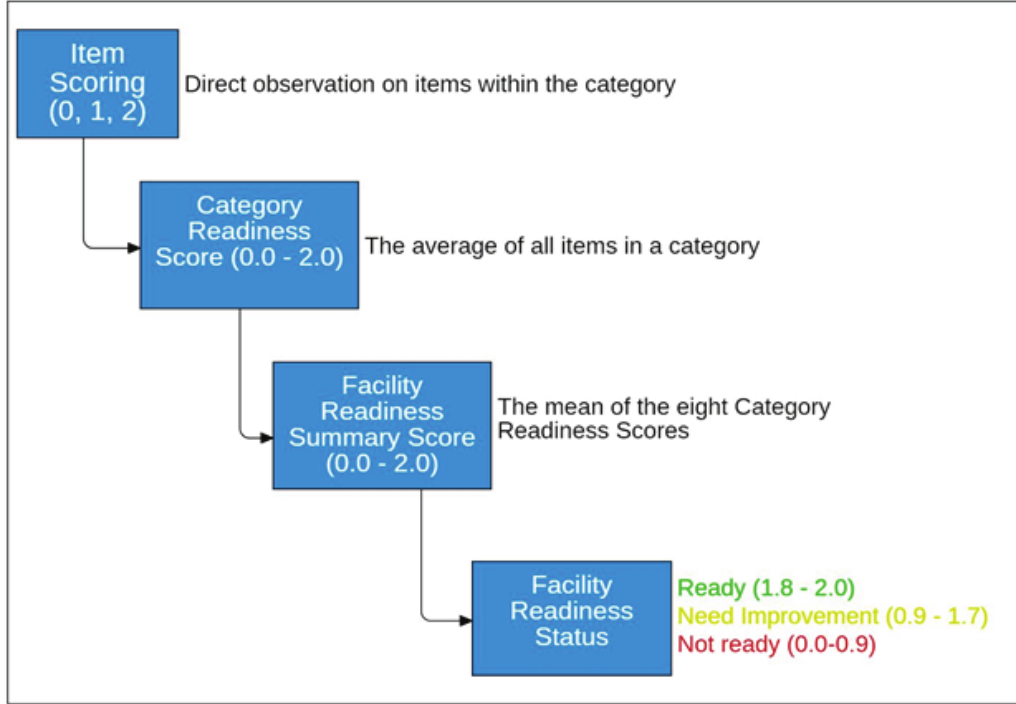
Figure 2: Process of facility readiness status